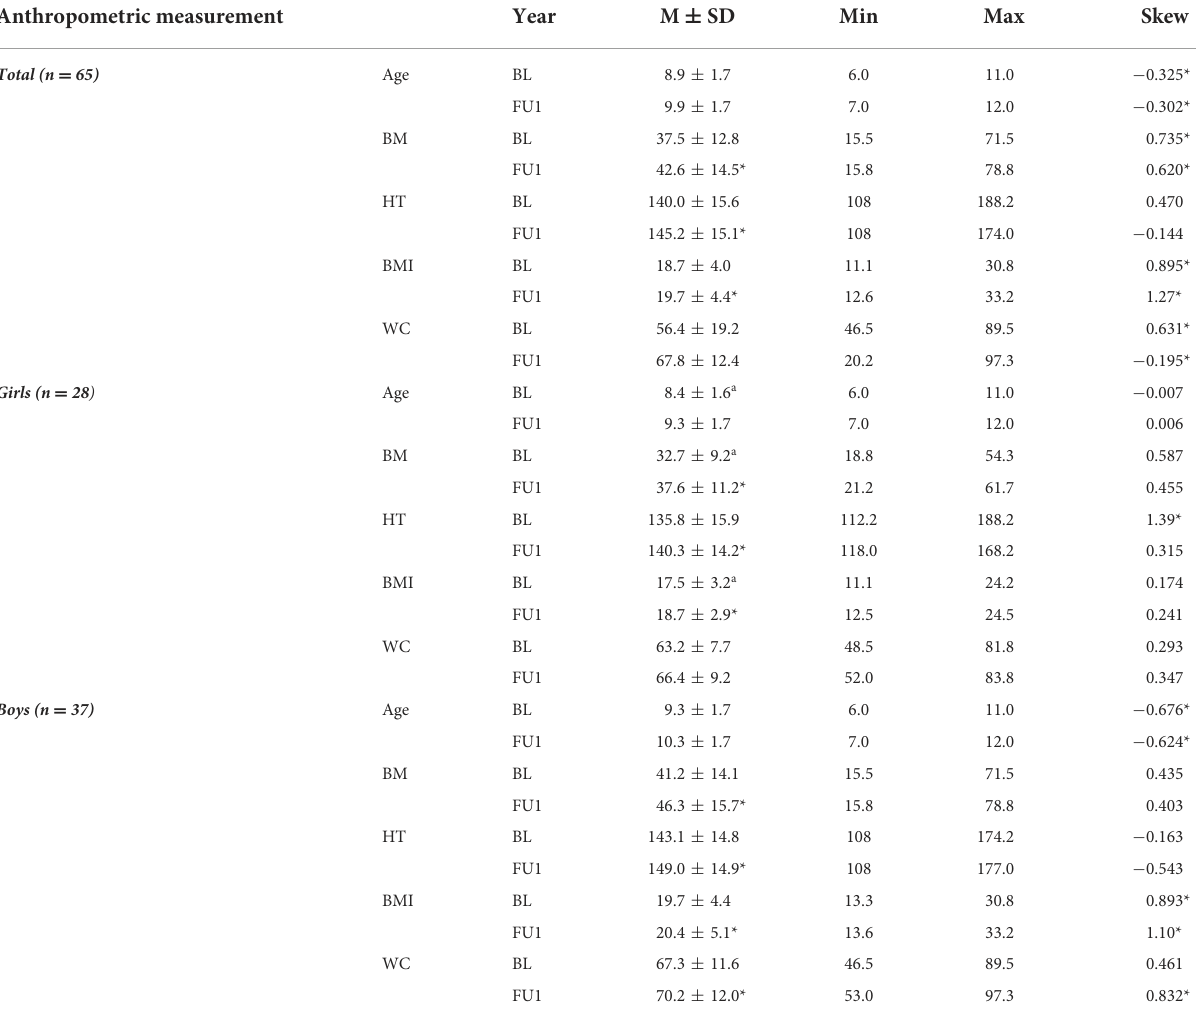
TABLE 1 Participant characteristics described by means and standard deviations (M ± SD), minimum, maximum, and normality with Shapiro-Wilk skewness statistic for selected body composition measures obtained during summer camps at baseline (BL) and 1-year later (FU1). Anthropometric